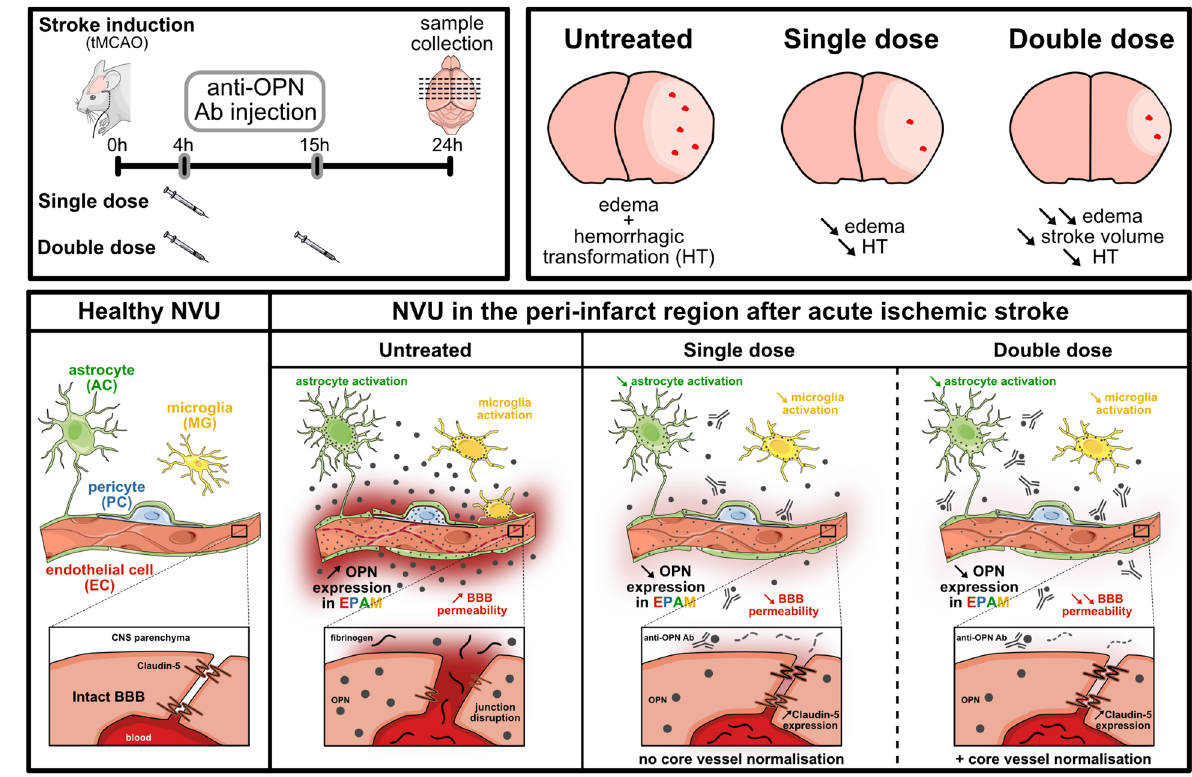
Figure 6. Cerebroprotective effect of antibody-mediated neutralization of dysregulated osteopontin at the neurovascular unit in acute ischemic stroke. Summary schematic depicting the anti-osteopontin antibody treatment regimens (top left panel) 4 h (single treatment duringt early acute phase) or 4 h and 15 h (combined treatment during early and late acute phase) after transient occlusion of middle cerebral artery (tMCAO) and their effects on dysregulated neurovascular unit (NVU) and blood–brain barrier (BBB) function in the ischemic cerebrovascular bed (bottom panel) and on hemorrhagic transformation, cerebral edema formation and stroke volume (top right panel) 24 h post-tMCAO in